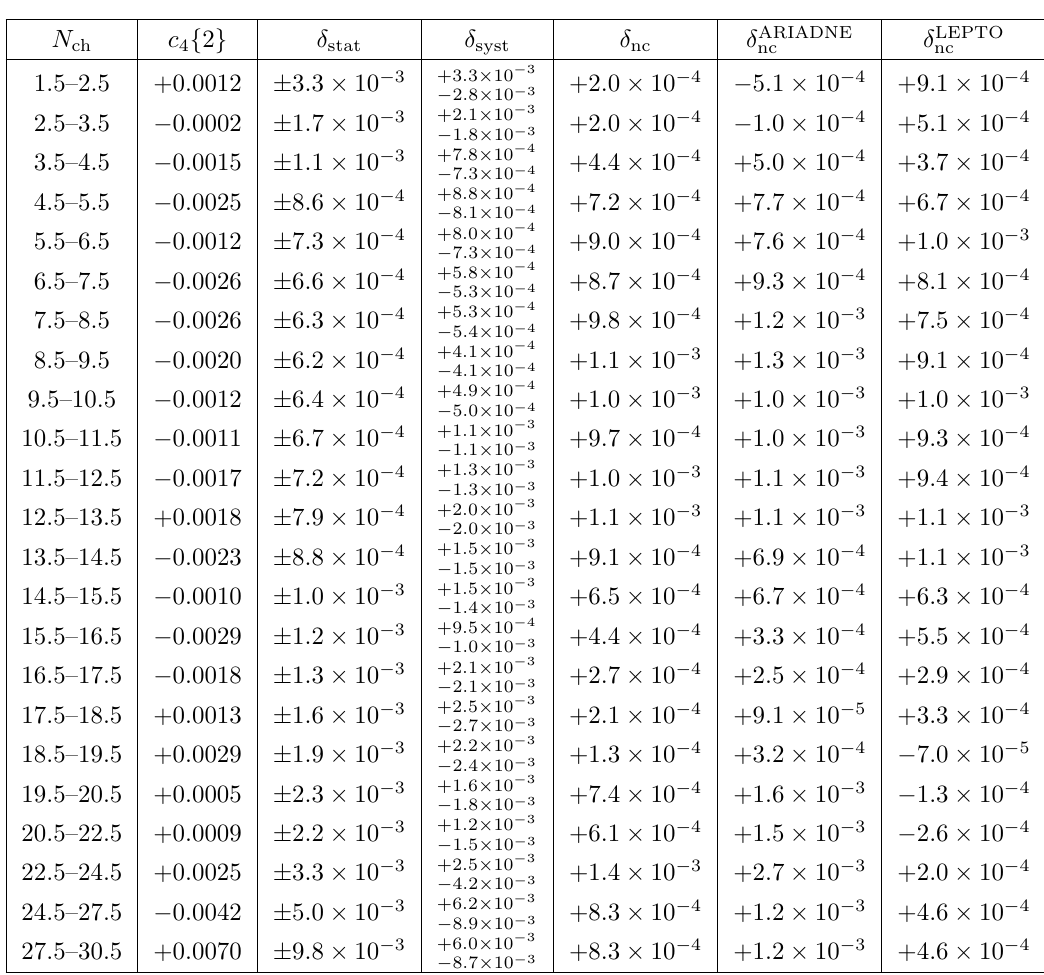
Table 12 . c 4 f 2 g versus N ch from (cid:12)gure 7 (d), p T > 0 : 5 GeV, j (cid:1) (cid:17) j > 2; (cid:14) stat , (cid:14) syst and (cid:14) nc denote the statistical, systematic and Monte Carlo non-closure uncertainties,